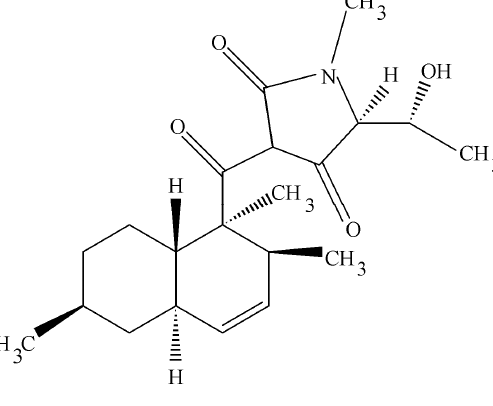
Figure 7. The structure of cryptocin.